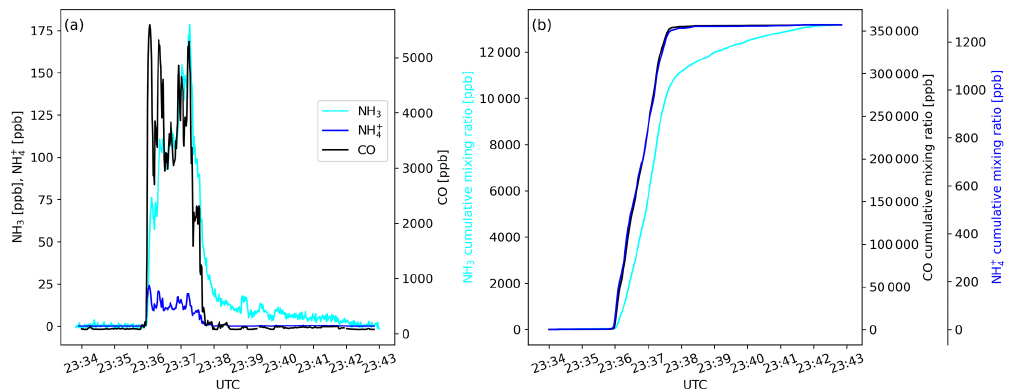
+ and CO and of (b) cumulative mixing ratios of NH 3 , NH + 4